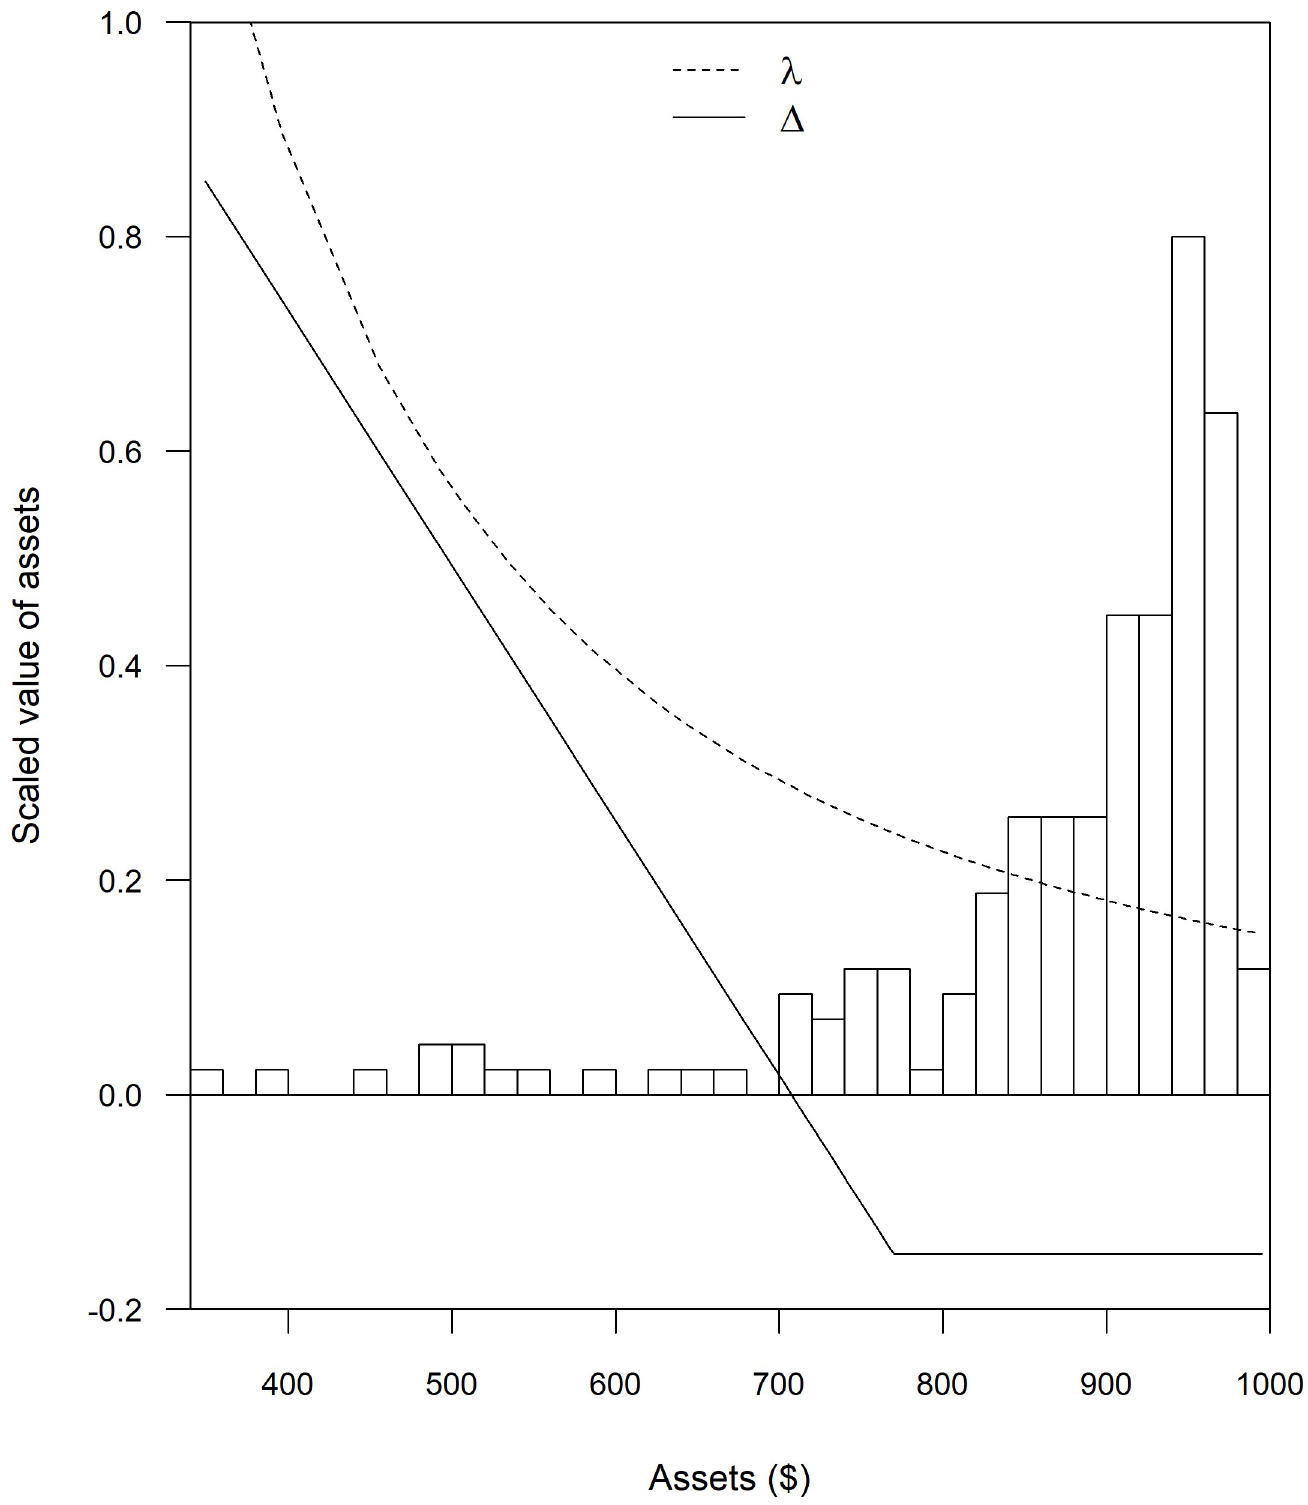
Fig 2. Elements of insurance benefit: The shadow value of money ( λ ), insurance benefit ( Δ ), and an empirical distribution (histogram) of the probability of the livestock assets remaining after accounting for mortality expressed in USD. To combine these measures on one figure, the y-axis was scaled to values shown on the